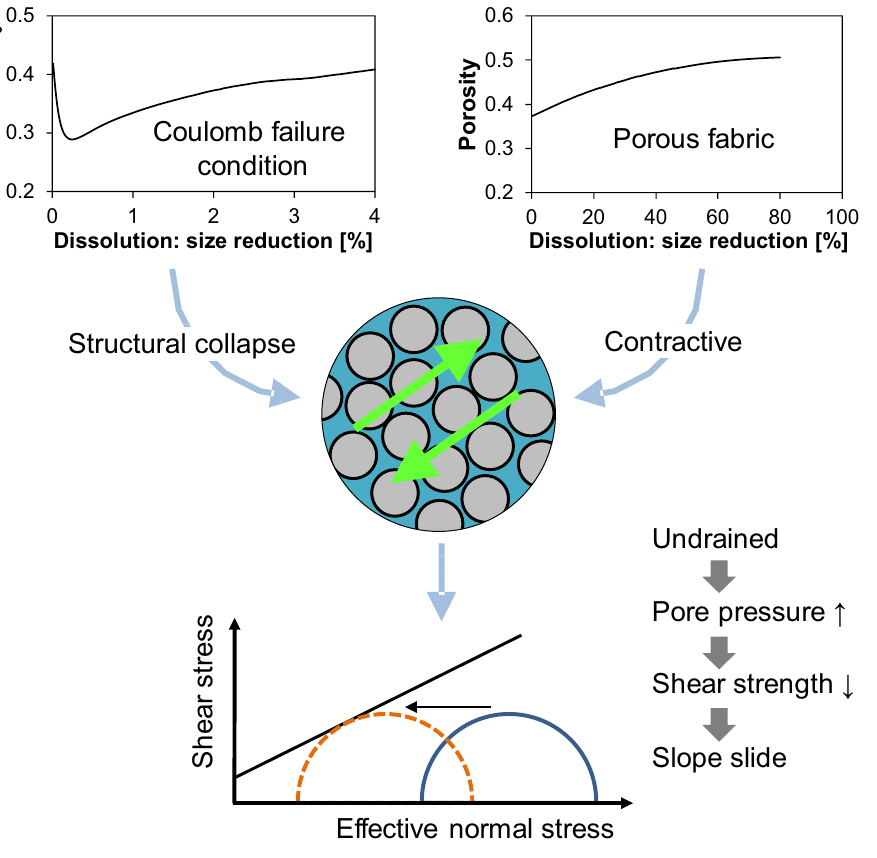
Figure 3. Sequence of conditions leading to the slide. The stress ratio K 0 and porosity are from the three- dimensional discrete element simulations in Cha and Santamarina 47 .